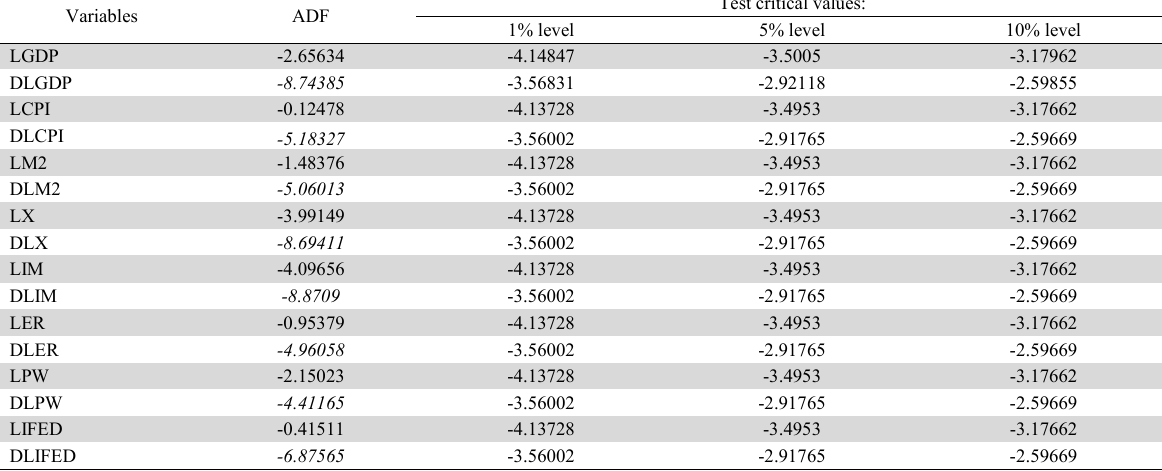
Source: VAR model results